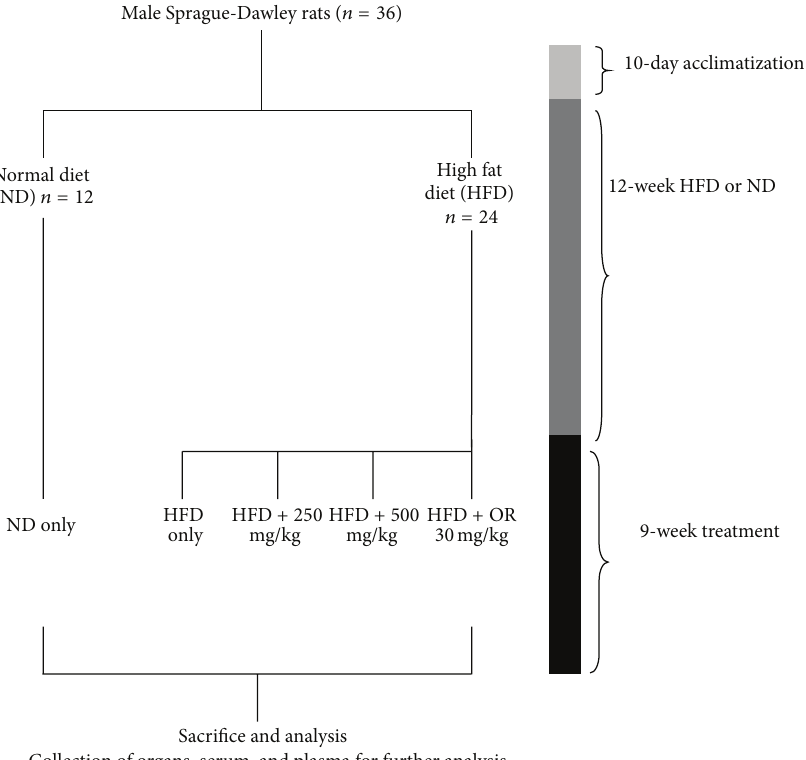
Figure 1: Schematic diagram of the experimental design to assess the antiobesity effect of MLE 60 in HFD induced obese male Sprague- Dawley